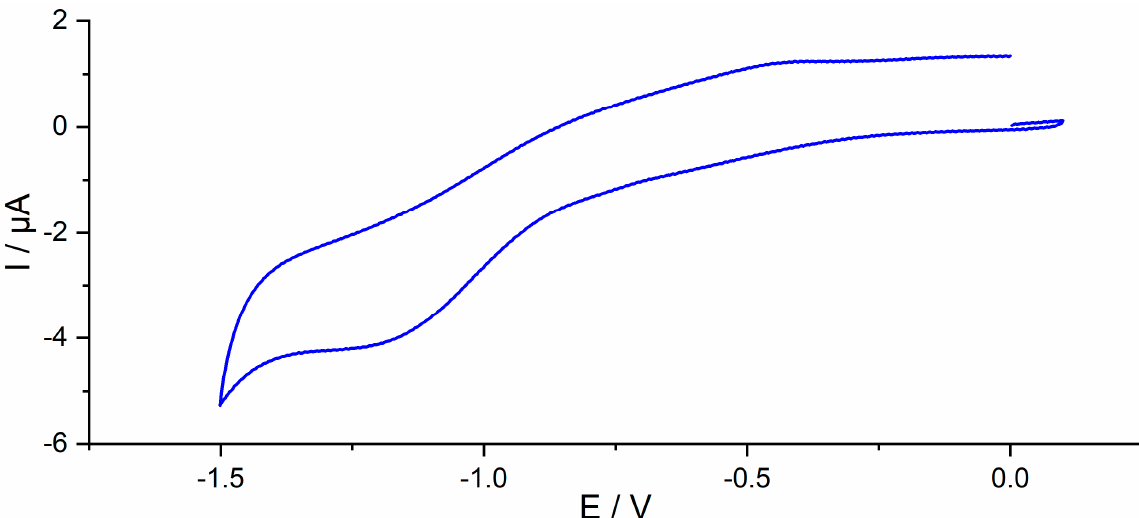
CFO (30 mg ∙ L − 1 ) in THF (0.1 mol ∙ L –3 NBu 4 PF 6 ) at 298.15 K. v = 0.1 V ∙ s –1 . CFO (30 mg · L − 1 ) in THF (0.1 mol · L –3 NBu 4 PF 6 ) at 298.15 K. v = 0.1 V · s –1